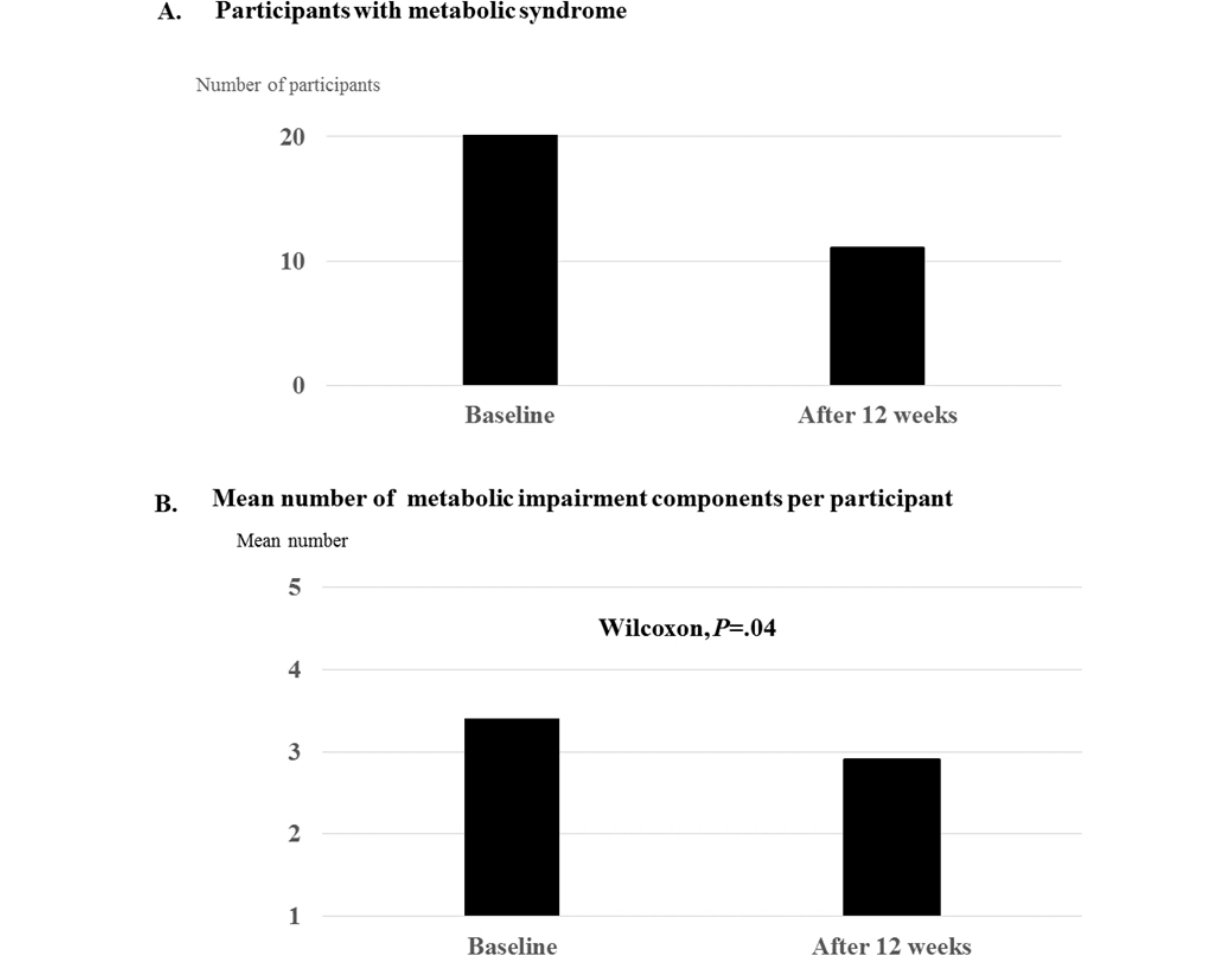
Figure 4. Change in the metabolic abnormality status in study participants from baseline to follow-up at 12 weeks. (A) Resolution of metabolic syndrome. (B) Changes in components of metabolic